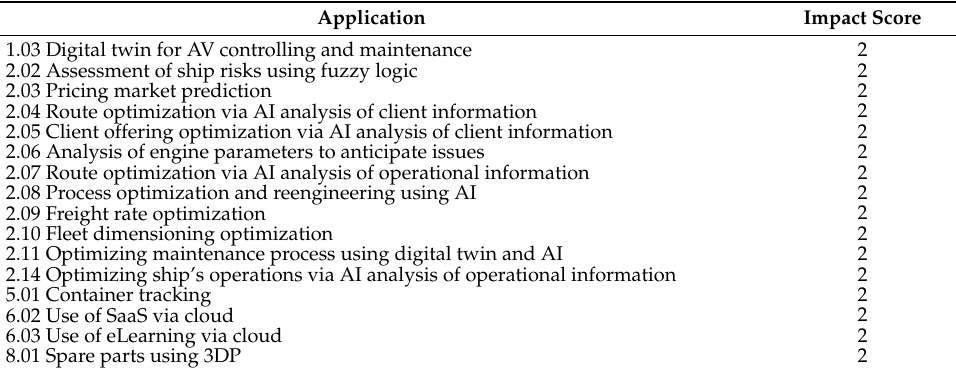
Table 12. Top applications on Flexibility performance dimension.